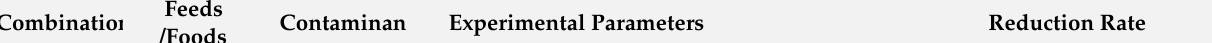
Table 4. Subsequent techniques to mitigate mycotoxins in solid foods and